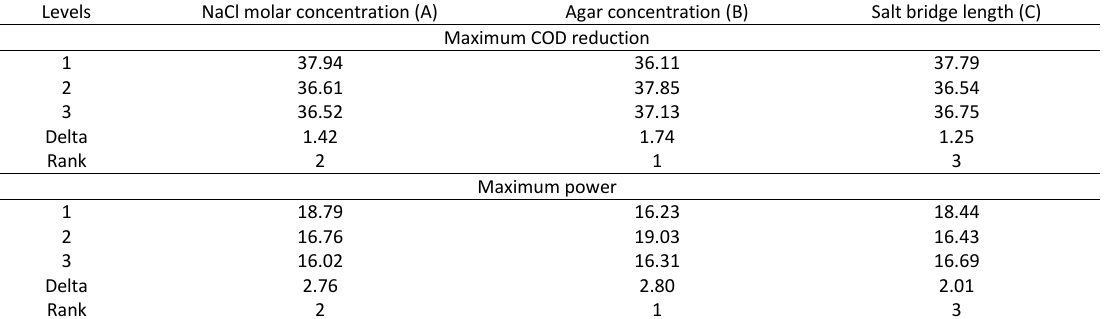
Table 6: The response for S/N ratio from run 1 to run 9